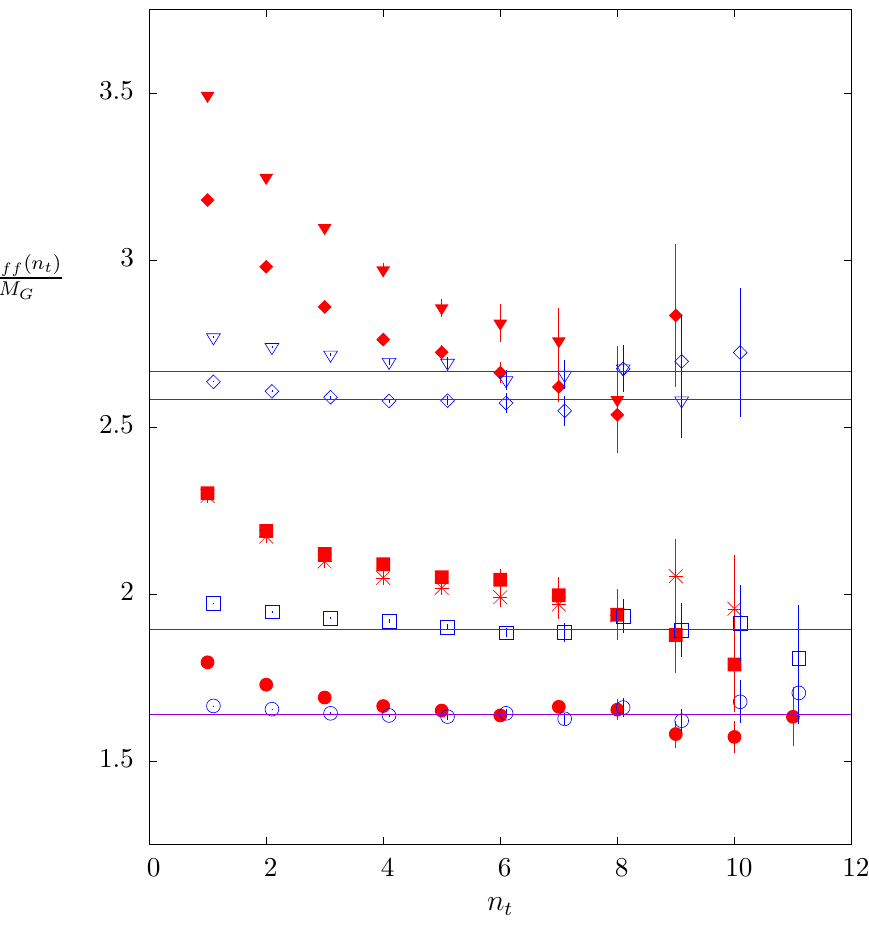
Figure 7 . E(cid:11)ective SO(3) masses of the lightest two 2 (cid:0) glueballs ( (cid:15) , (cid:4) ), the lightest 0 (cid:0) glueball ( (cid:7) ) and the lightest 1 (cid:0) glueball ( H ), with open points being the corresponding SU(2) e(cid:11)ective masses. Also the SO(3) mass of the (cid:12)rst excited 2 + ( ? ). All in units of their respective mass gaps and on the same lattices as in (cid:12)gure 6. Lines are SU(2) mass estimates. The 0 (cid:0) and 1 (cid:0) values have been shifted upwards by 0.5 for